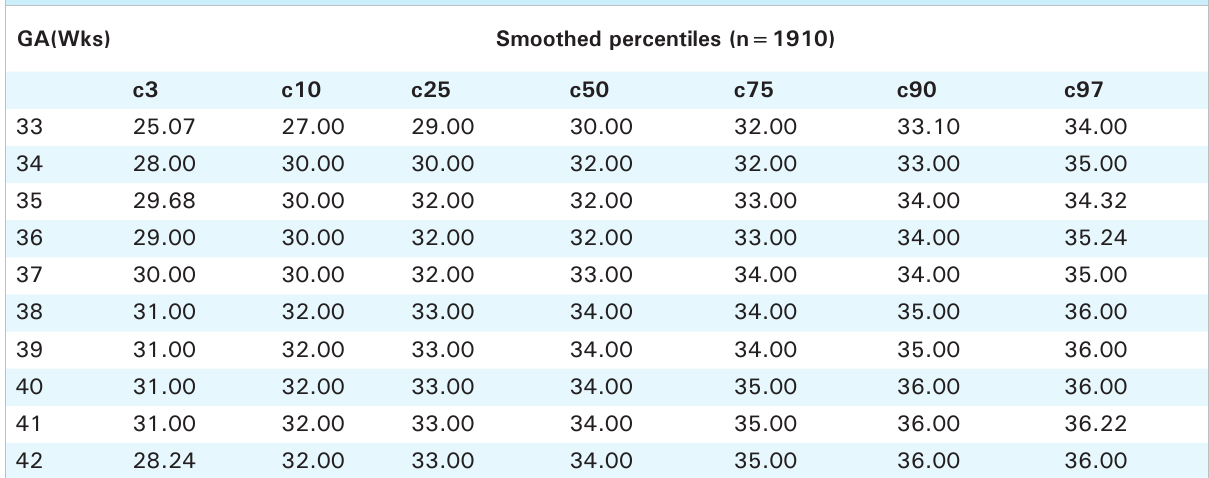
Table 4. Smoothed percentile values of head circumference for each gestation from 33 to 42 weeks.